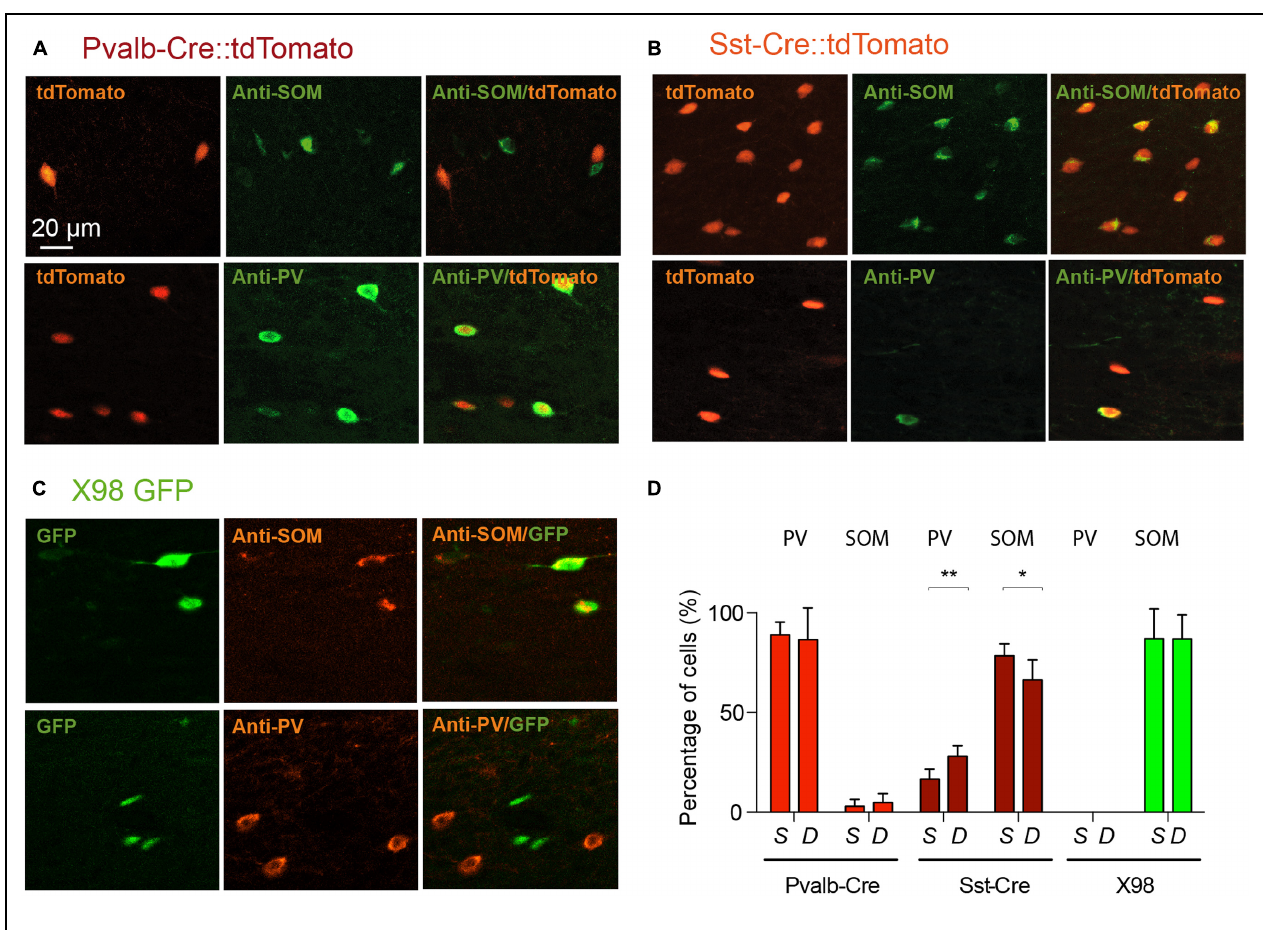
FIGURE 3 | Verification by PV or SOM immunostaining of the identity of labeled neurons from Pvalb-Cre tdTomato, Sst-Cre tdTomato, or X98 GFP animals. Presubicular sections from (A) , Pvalb-Cre tdTomato mice and (B) Sst-Cre tdTomato mice, both with maternal cre inheritance, and (C) , X98 GFP mice, immunostained with anti-SOM (top) and anti-PV antibodies (bottom). For each panel